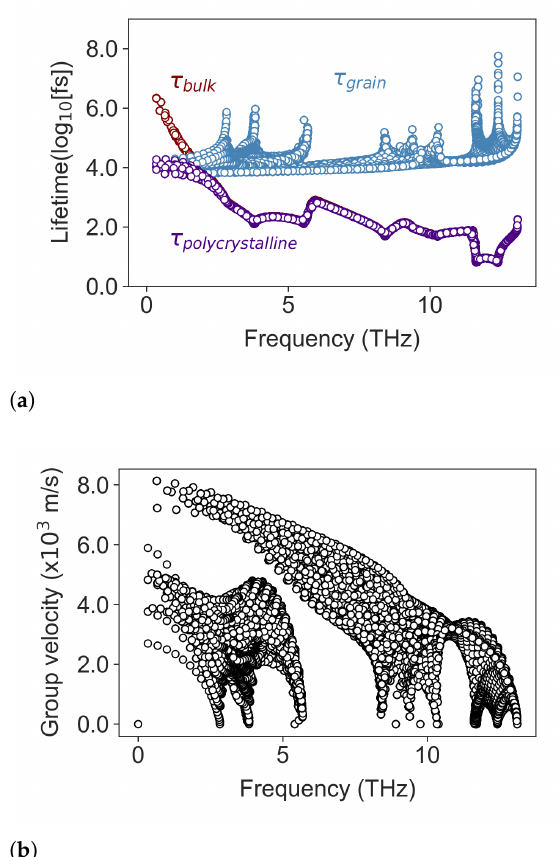
Figure 1. ( a ) Phonon lifetimes vs. frequency. The lifetime τ bulk due to phonon–phonon and phonon– alloy scattering processes in single crystal Si 0.8 Ge 0.2 at 500 K is plotted in red. The lifetime τ grain , due to grain boundary scattering in a microstructure with l g = 50 nm is plotted in blue, and the total lifetime in from the combination of τ bulk and τ grain is plotted in purple. ( b ) The phonon group velocity used in the calculation of τ grain